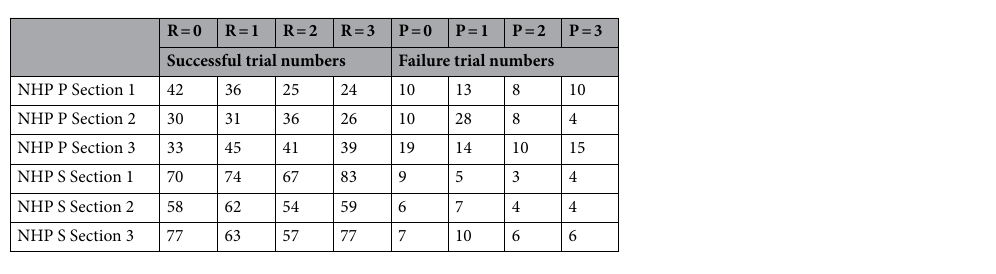
Table 4. Trial numbers for each R and P